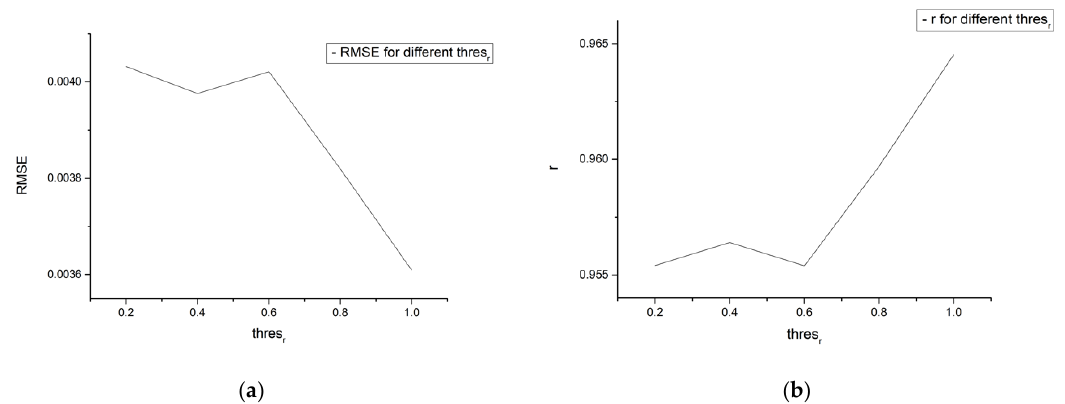
Figure 14. The ( a ) RMSE and ( b ) r of the fusion results with applying different thresholds for correlation coefficient in the HNN-SPOT algorithm.